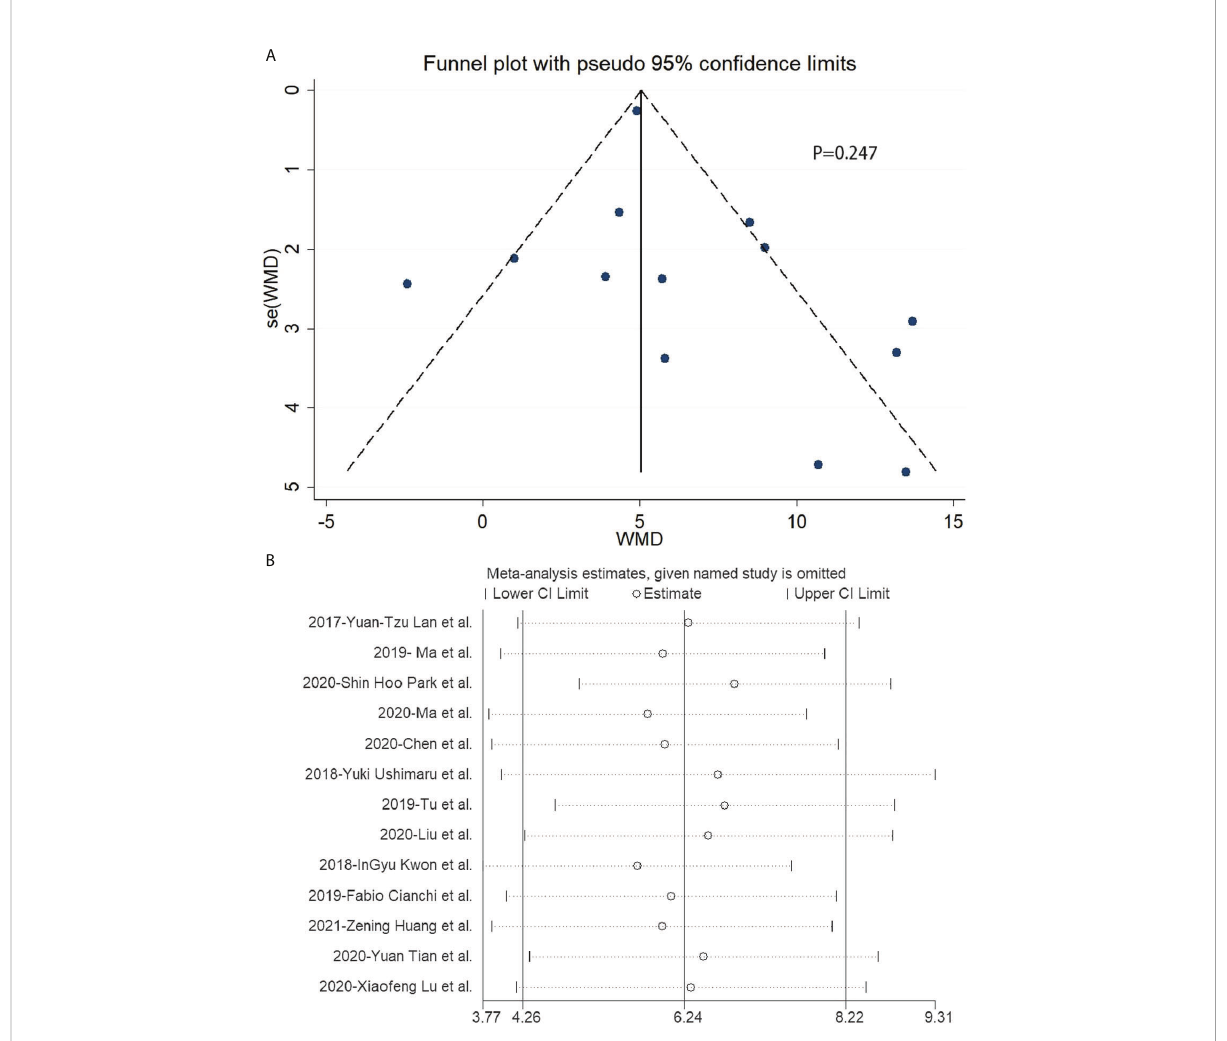
FIGURE 5 Funnel plot and sensitivity analysis of included studies related to laparoscopic gastrectomy with indocyanine green. (A) Funnel plot of included studies related to laparoscopic gastrectomy with indocyanine green. (B) Sensitivity analysis of included studies related to laparoscopic gastrectomy with indocyanine green.